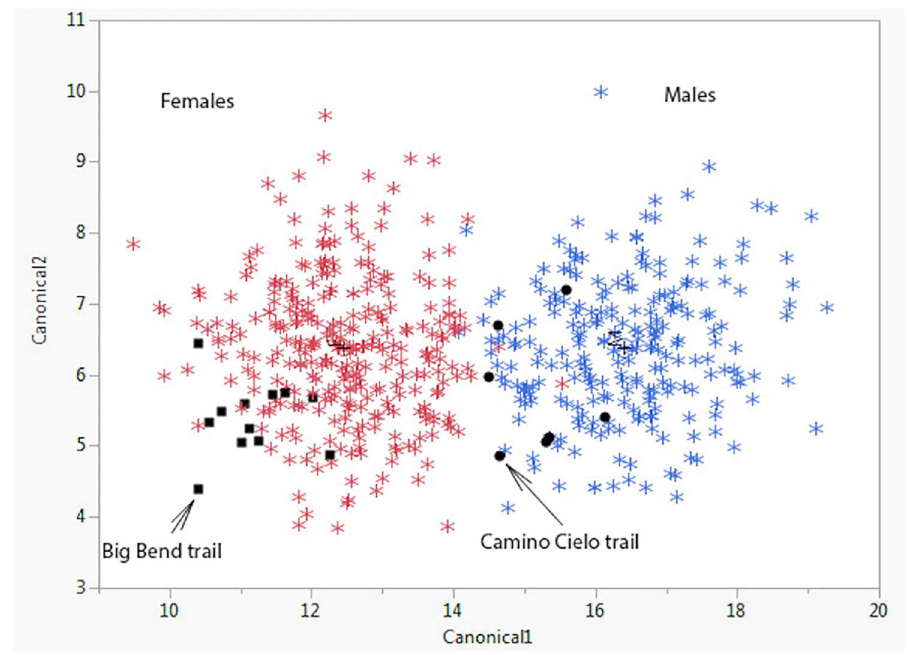
Fig 11. Scatterplot showing the distribution of footprints by sex. Red stars are footprints from females, and blue from males. The black squaresand circles are from animalsof unknownsex from Big Bend (classifiedas female) and CaminoCielo(classifiedas male)